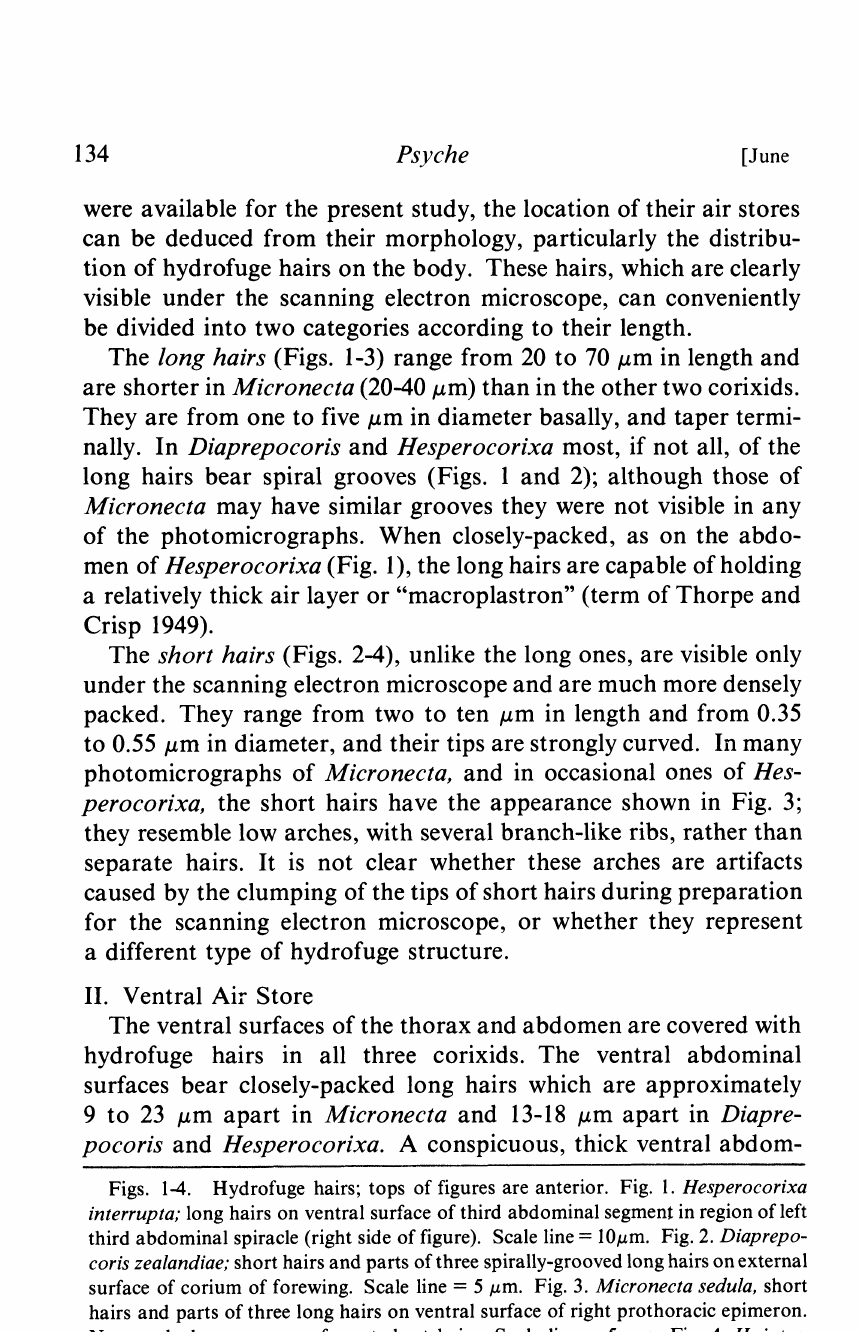
interrupta; long hairs on ventral surface of third abdominal segment in region of left third abdominal spiracle (right side of figure). Scale line 10#m. Fig. 2. Diaprepo- coris zealandiae; short hairs and parts of three spirally-grooved long hairs on external surface of corium of forewing. Scale line 5 #m. Fig. 3. Micronecta sedula, short hairs and parts of three long hairs on ventral surface of right prothoracic epimeron. Note arched appearance of most short hairs. Scale line 5 #m. Fig. 4. H. inter- rupta; short hairs on ventral surface of right prothoracic epimeron. Scale line 2